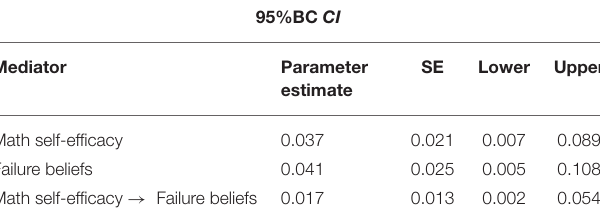
TABLE 3 | Bootstrapping analysis of the mediating effect.